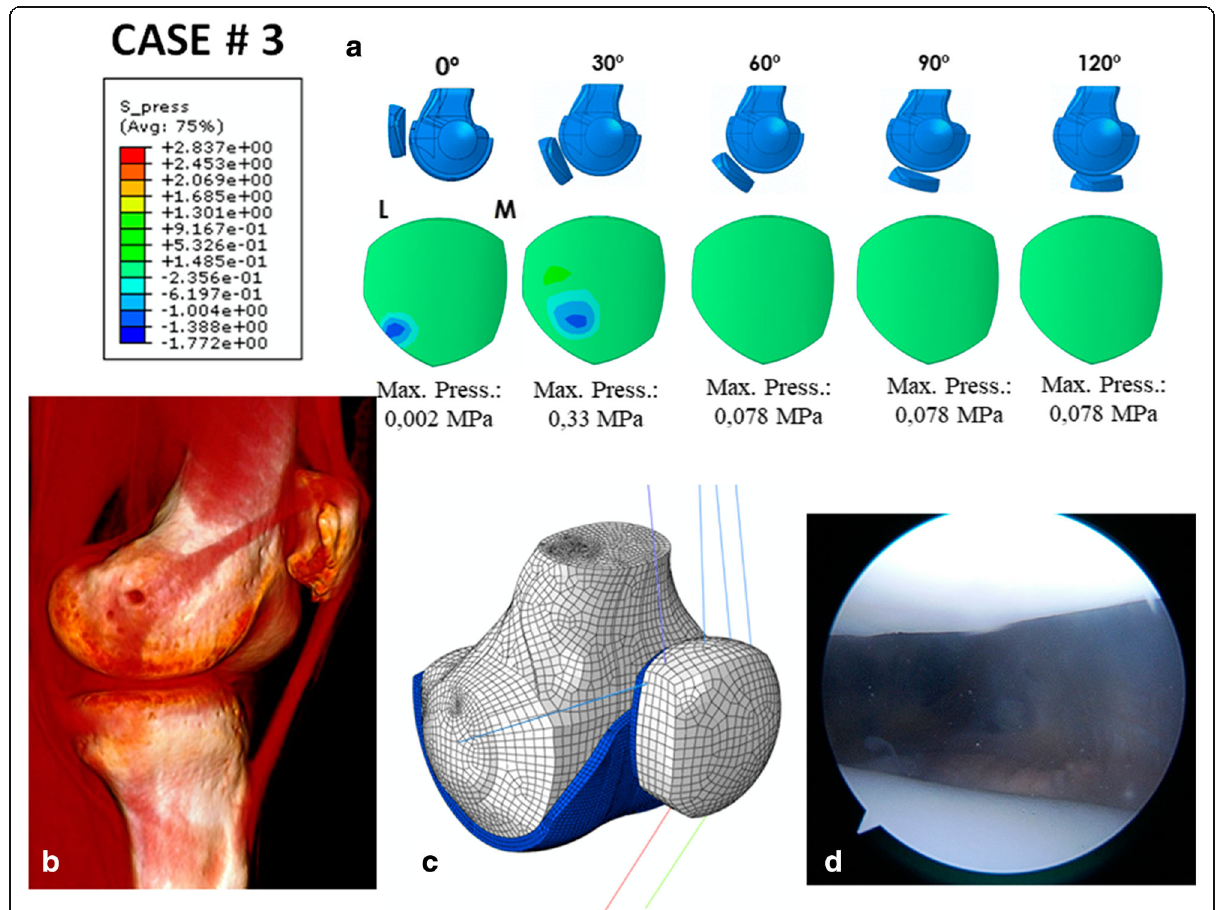
Fig. 6 Case # 3 Surgical failure: a Contact pressure (MPa) on the patellar cartilage L = Lateral M = Medial. b One can see that the graft is preserved; however, the orientation is too oblique and extremely vertical. c Parametric model of patient # 3. d Arthroscopy at the time of the revision surgery shows normal patellofemoral